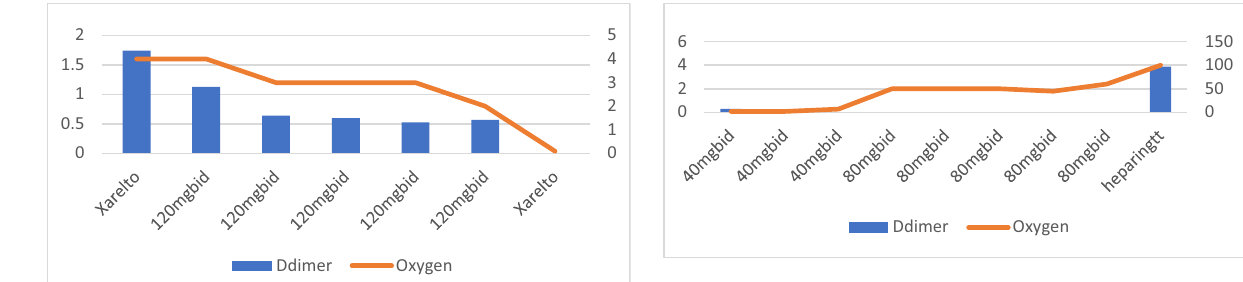
Figure 8: Patient number 8 presented at an early stage requiring nasal canula oxygen and D - dimer level was also low on presenta - tion. The D - dimer levels are missing during the hospital stay, but the fi gure shows the increasing trends of oxygen requirements. The patient on admission had A Fib with rapid ventricular response which is also a hypercoagulable disease ( like COVID - 19 ) needing full anticoagulation from admission. There was delay of 72 h in increasing Enoxaparin doses ( from 40 mg SubQ BID to 80 mg SubQ BID ) leading to intra - aortic occlusion and subsequently patient expired.